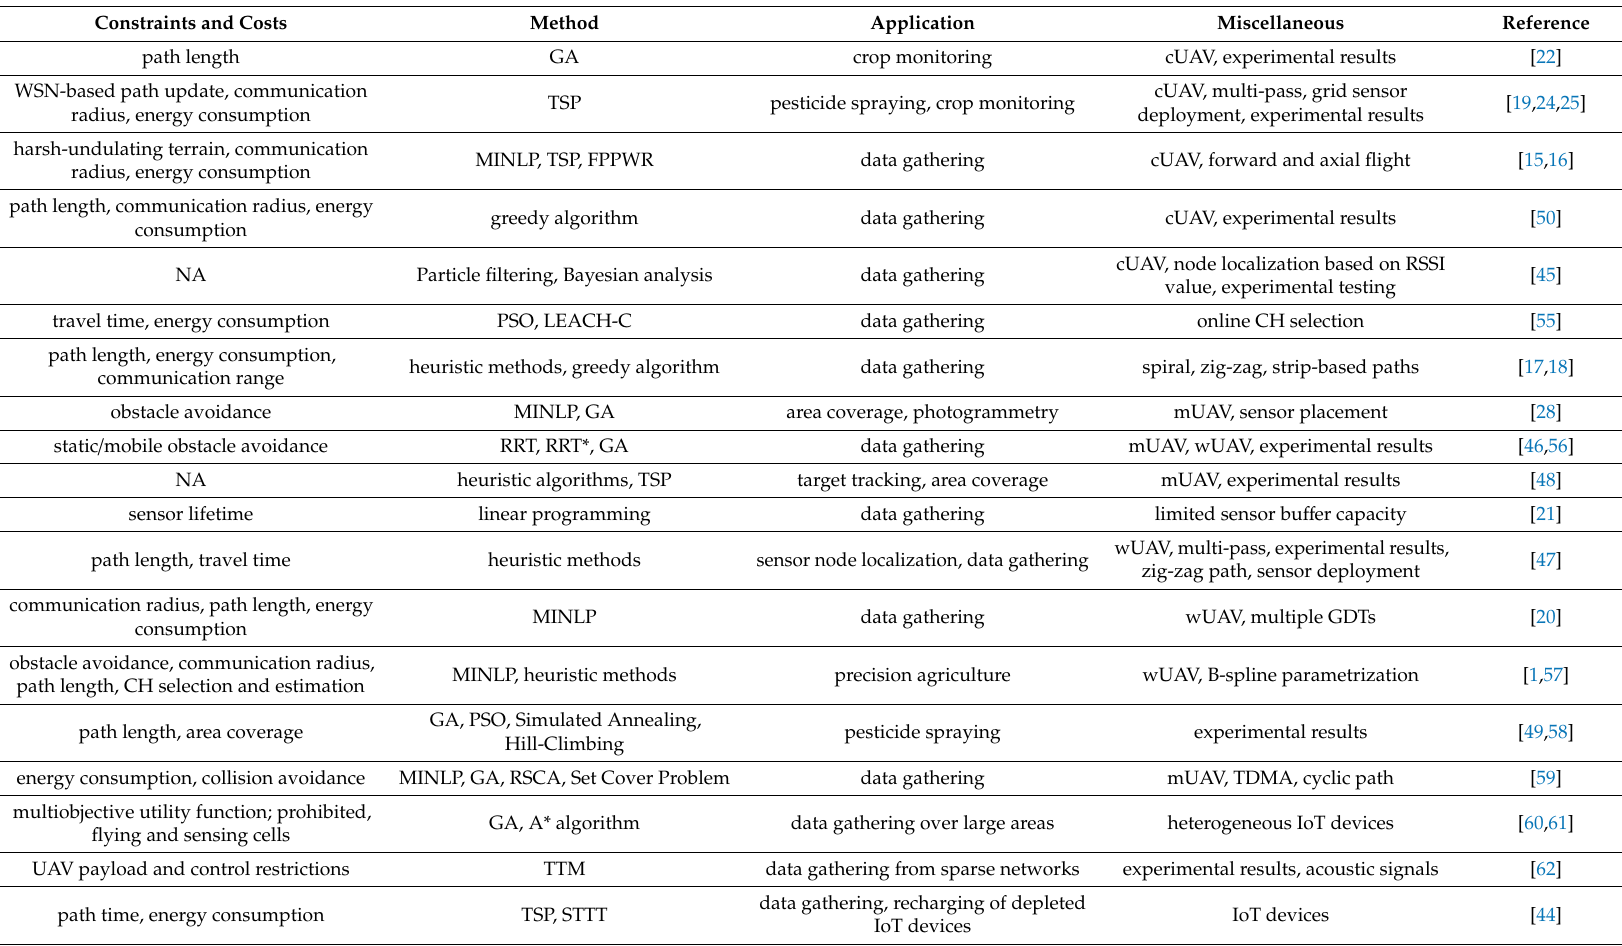
Table 1. Path planning for UAV–WSN